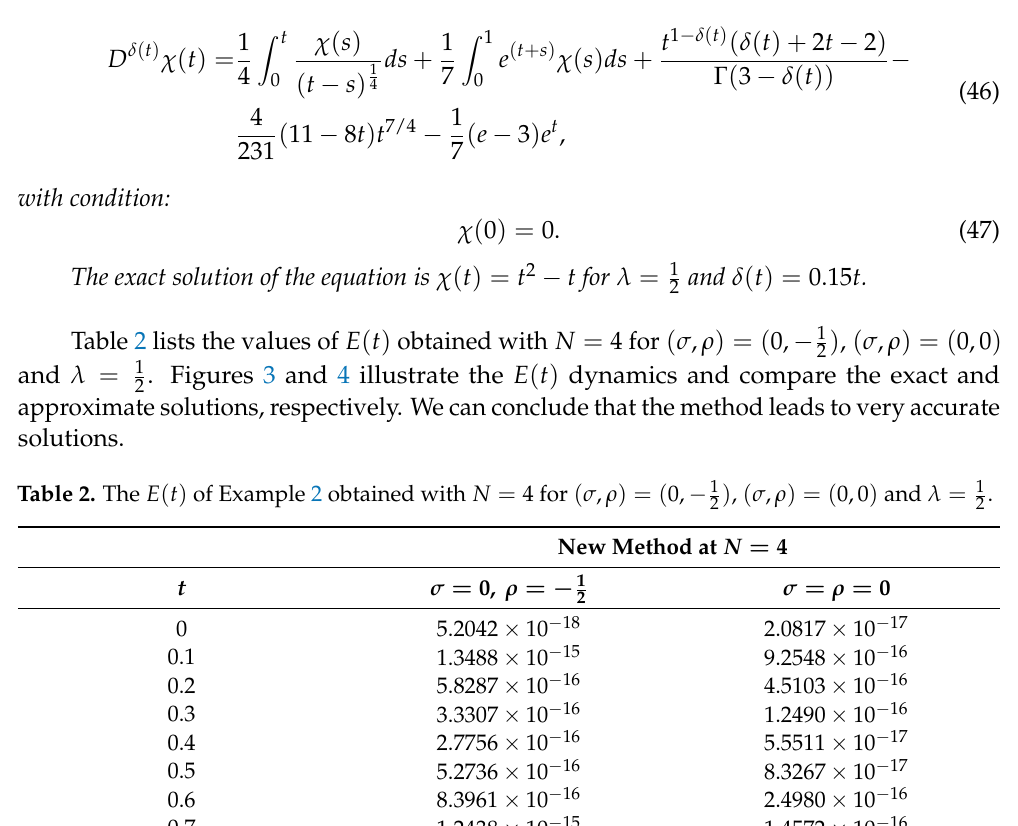
Figure 2. The approximate and exact solutions, χ N ( t ) and χ ( t ) , of Example 1 for N = 6 ( σ , ρ ) = ( 0, 1 λ = 1 . 2